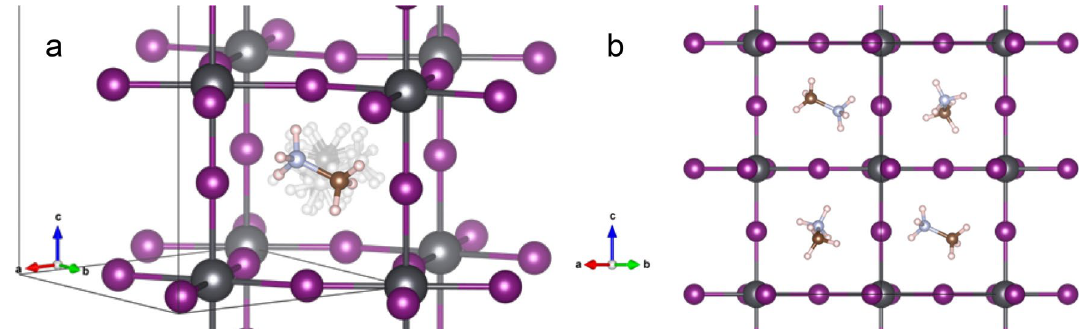
Figure 3. Two alternative views of the tetragonal structure observed at 298 K. ( a ) 3D view highlighting the octahedral tilting (a 0 a 0 c − ) and the superimposed CH 3 NH 3+ units, which are disordered in this temperature range (see text), ( b ) idealized projection along [110] showing four possible configurations of the CH 3 NH 3+ unit in adjacent